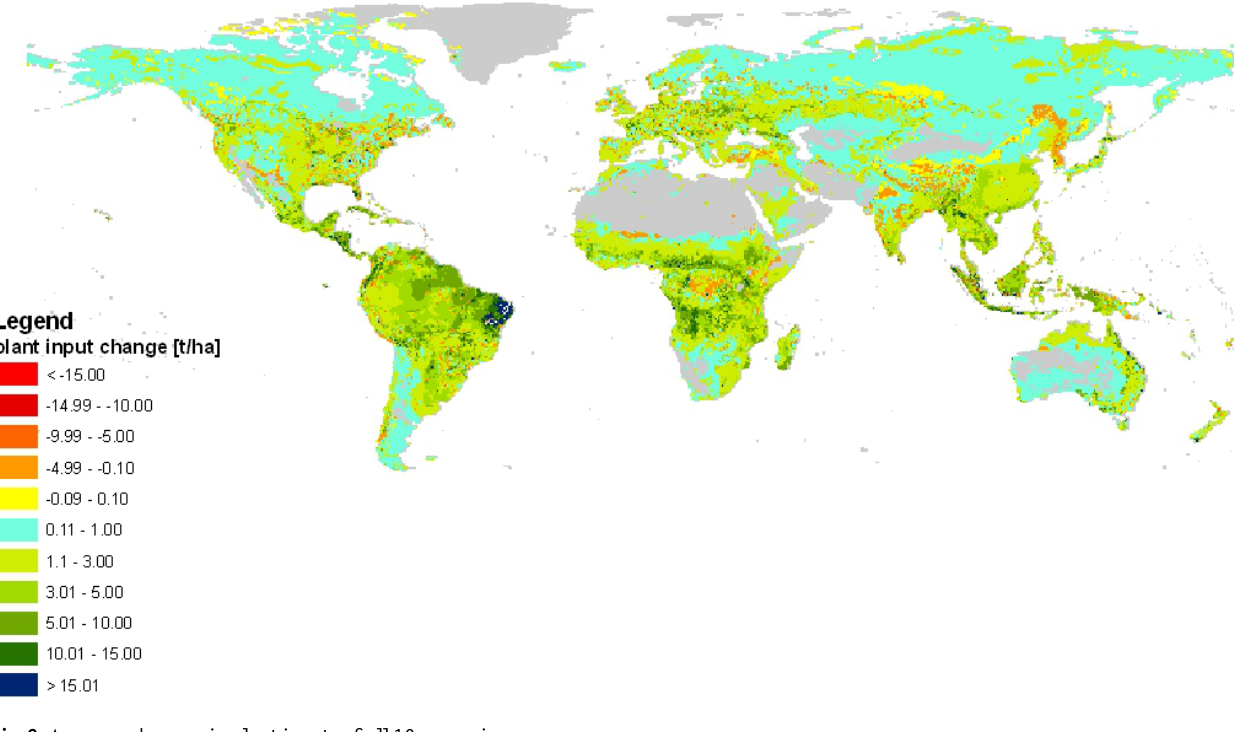
Fig. 9. Average changes in plant inputs of all 10